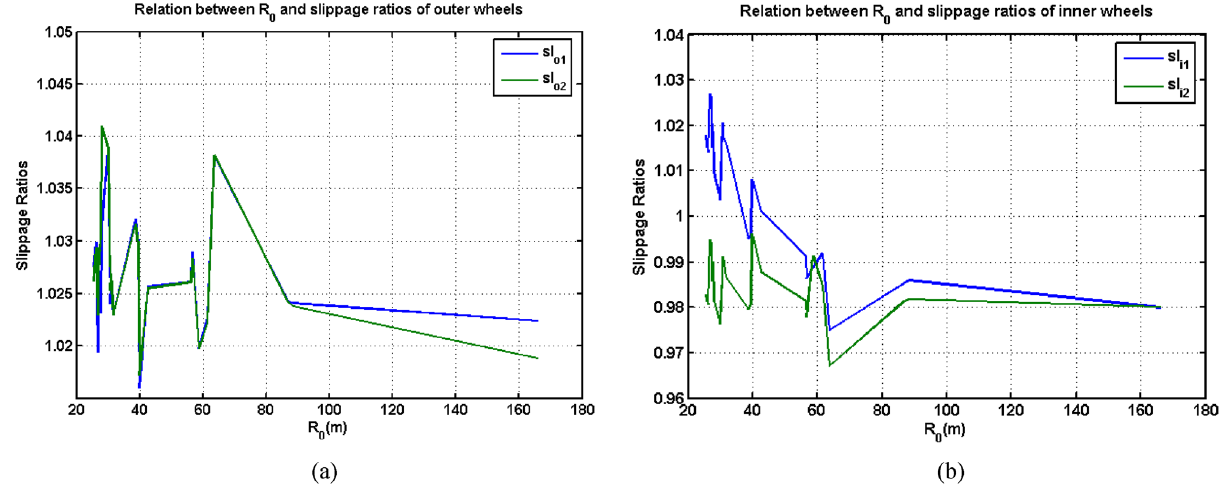
Figure 12. Relations between R 0 and slippage ratios ( a ) outer wheels, ( b ) inner